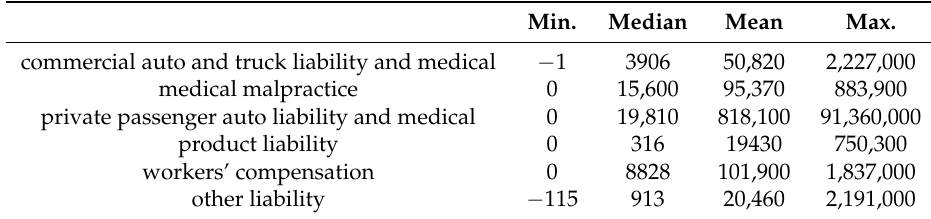
Table 4. Ranges of paid losses per business line.